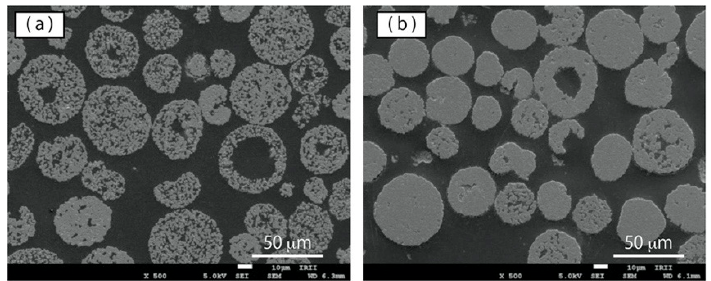
Figure 8. SEM observation of cross section of WC–12%Co powder particles: ( a ) raw powder, and ( b ) plasma-treated powder.